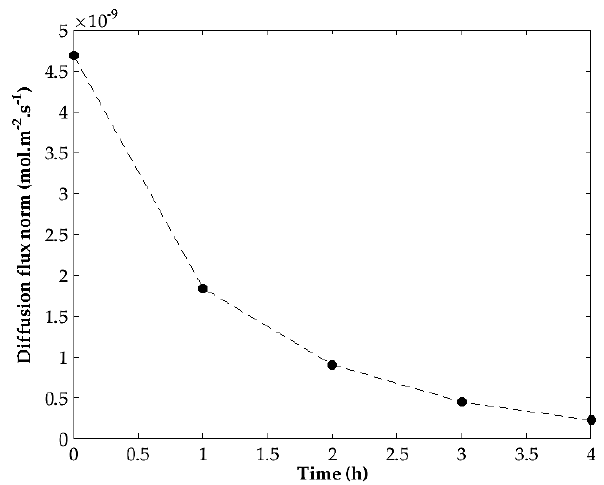
Figure 6. Numerical results according to a multi ‐ slice view: ( a ) 3D model meshed by FEM; ( b ) initial stage ( t = 0); and ( c ) final stage ( t = 4 h) of the PEG binder distribution during debinding by supercritical CO 2 under 40 MPa and 423.15 K.